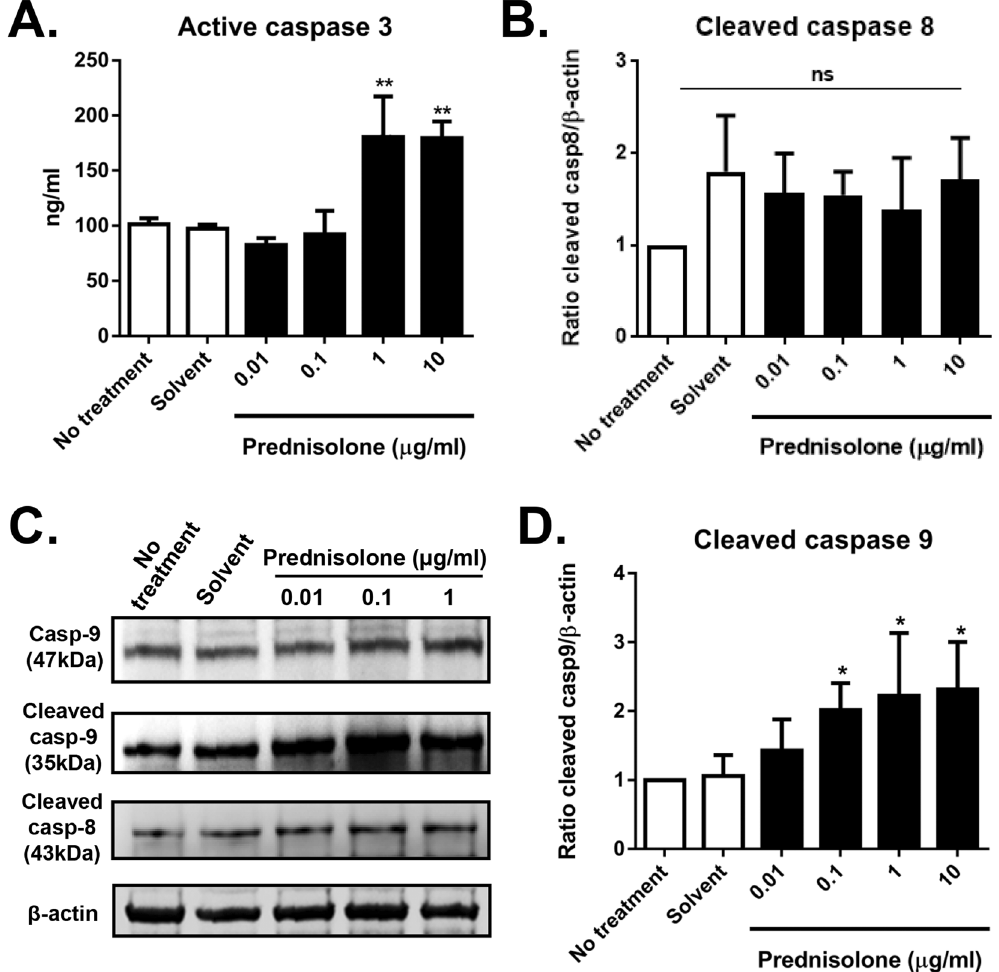
Figure 5. Effects of prednisolone on caspase activity and cleavage. ( A ) ELISA results for caspase-3 activity. ( B ) Densitometric analysis of the ratio of cleaved casepse-8 relative to β -actin. ( C ) Representative images of western blot analysis for pro-caspase-9 (Casp-9), cleaved caspase-9, cleaved caspase-8, and β -actin. Full, uncropped gel images are shown. ( D ) Densitometric analysis of the ratio of cleaved caspase-9 relative to β -actin. Data are presented as mean + SD from six independent sets of experiments. * p < 0.05, ** p < 0.01, ns: not